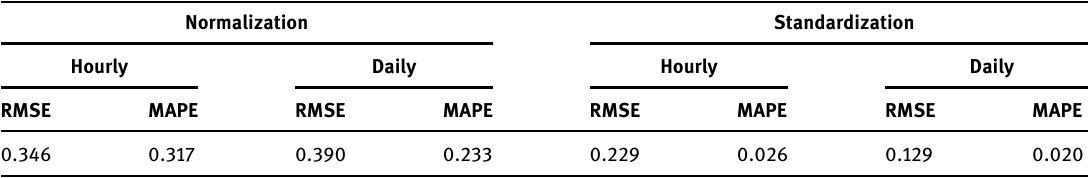
Table 2: Comparative results of the impact of the two scaling methods